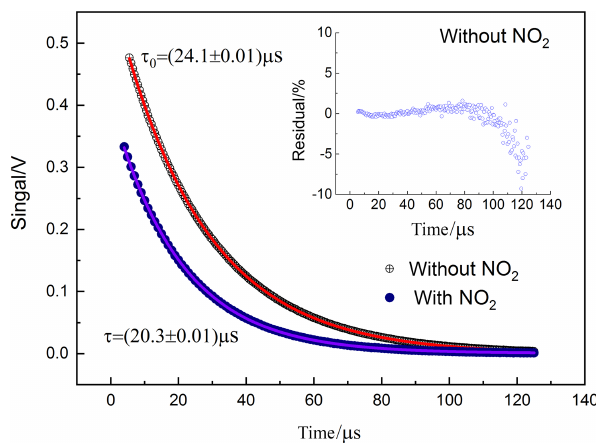
Figure 3. Different cavity ring-down signals and fitting results in the absence and presence of NO 2 . The small figure in the upper right corner is the fitting residual.